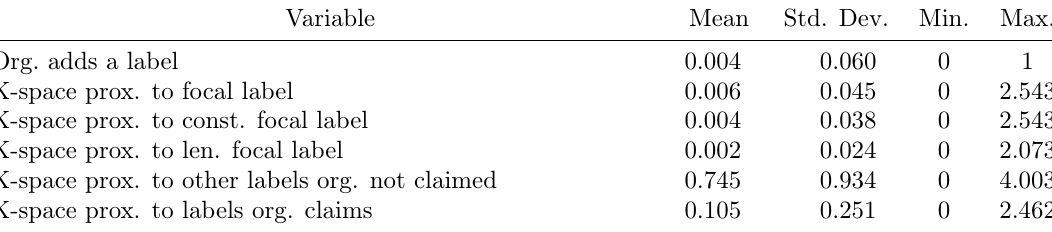
Table 1: Descriptive Statistics for Tests Involving the Hazard of Adding a Label. ( N = 1 , 434 , 096